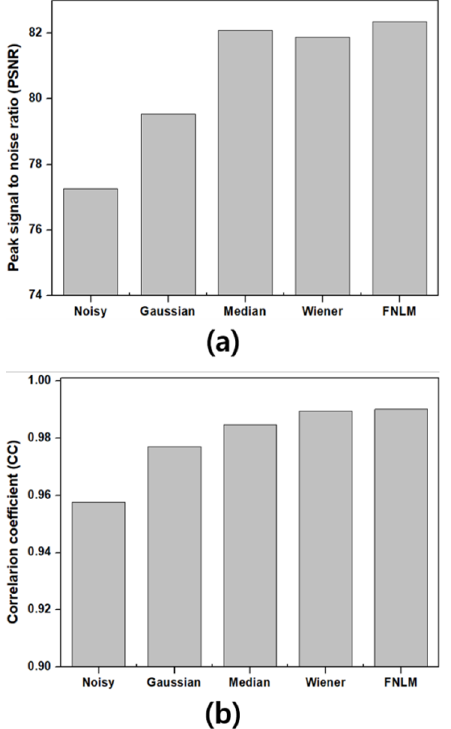
Figure 5. The ( a ) peak signal-to-noise ratio (PSNR) and ( b ) correlation coefficient (CC) values used to evaluate the similarity between the reconstructed images and original image.